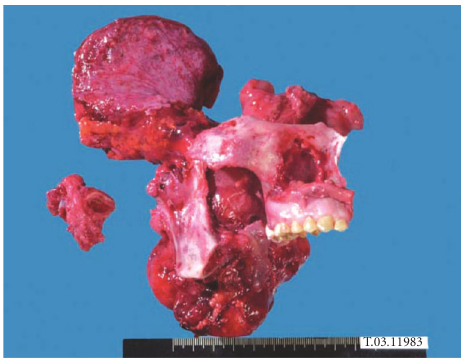
Figure 3: Surgical specimen including maxillectomy, segmental mandibula resection, and selective neck dissection.